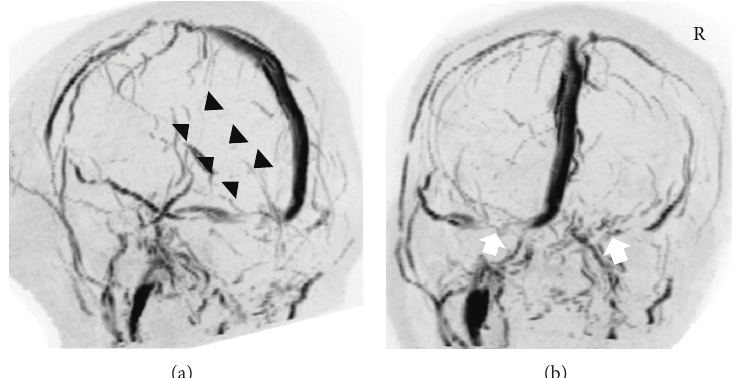
Figure 2: Two days after admission, magnetic resonance venography (MRV) showed an absence of flow in the inferior sagittal sinus, vein of Galen, and straight sinus (a), and a reduction of flow in the transverse sinus (b).